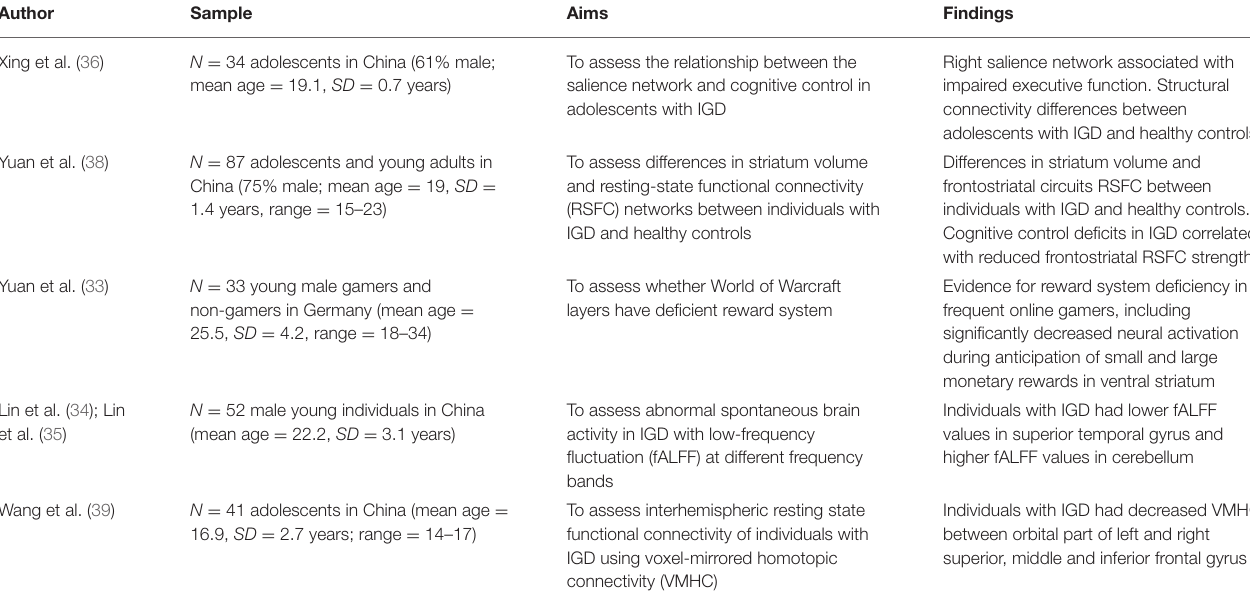
TABLE 2 | Resting state magnetic resonance imaging (rsfMRI) studies of Internet Gaming Disorder (IGD).